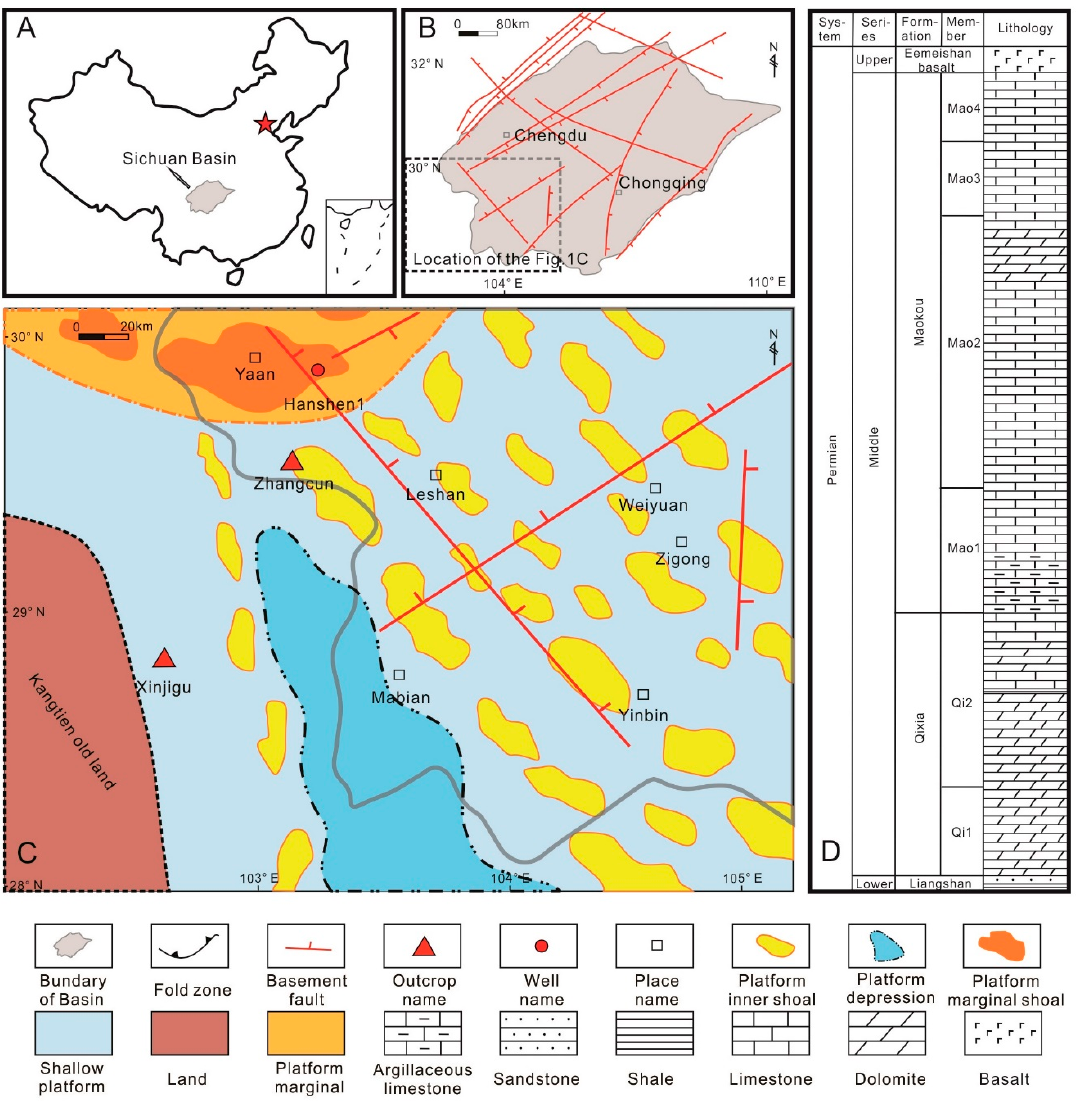
Figure 1. ( A ) Simplified location map of the Sichuan Basin. ( B ) Basement faults in the Sichuan Basin. ( C ) The location of study outcrops, wells, and sedimentary map of the Middle Permian (according to Zhou [29]). ( D ) Stratigraphic column of the Middle Permian in the southwest (SW) Sichuan Basin.